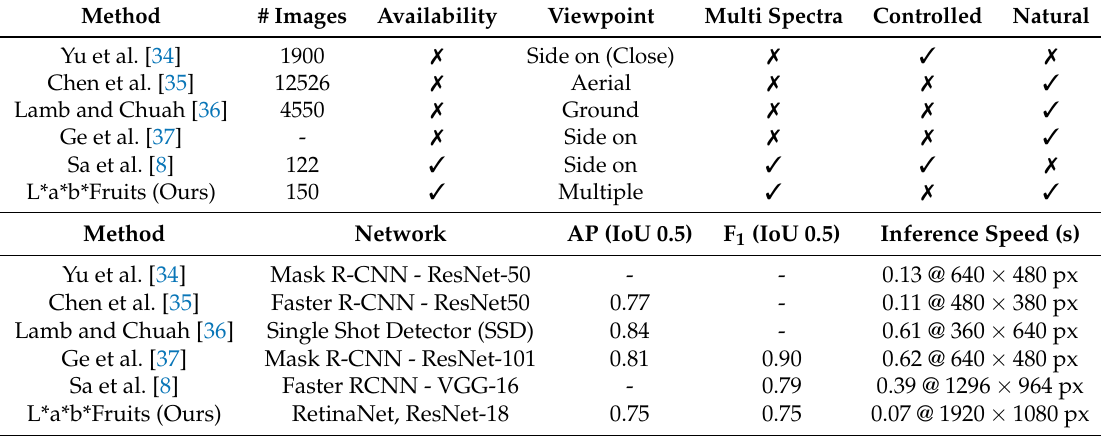
Table 1. Summary of SOTA (state-of-the-art) approaches to Strawberry Detection in Deep